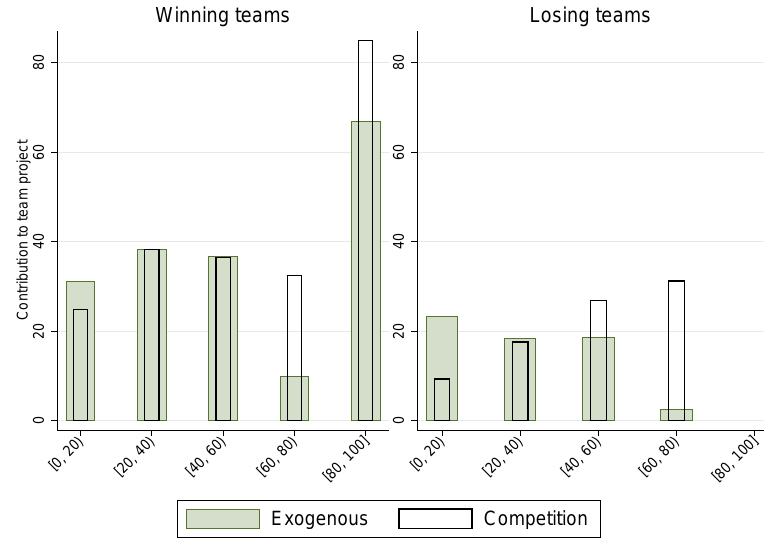
Figure 3. Contribution to the team project in relation to individual lottery tickets